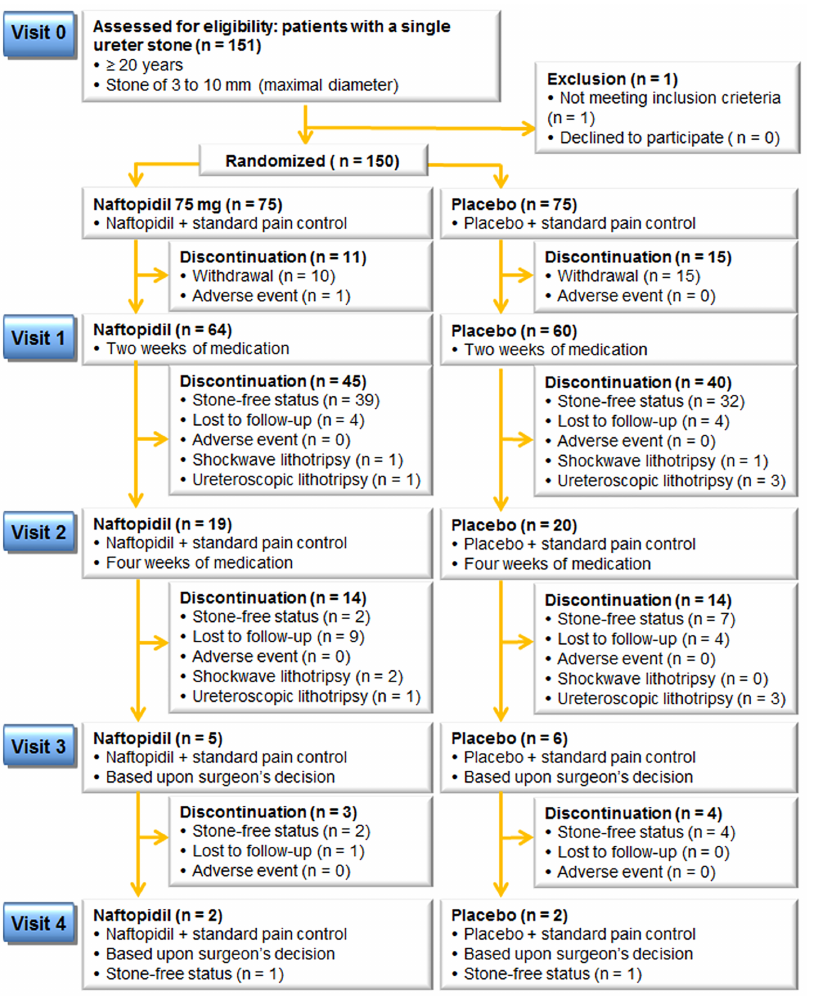
Fig 1. Flow diagram of the